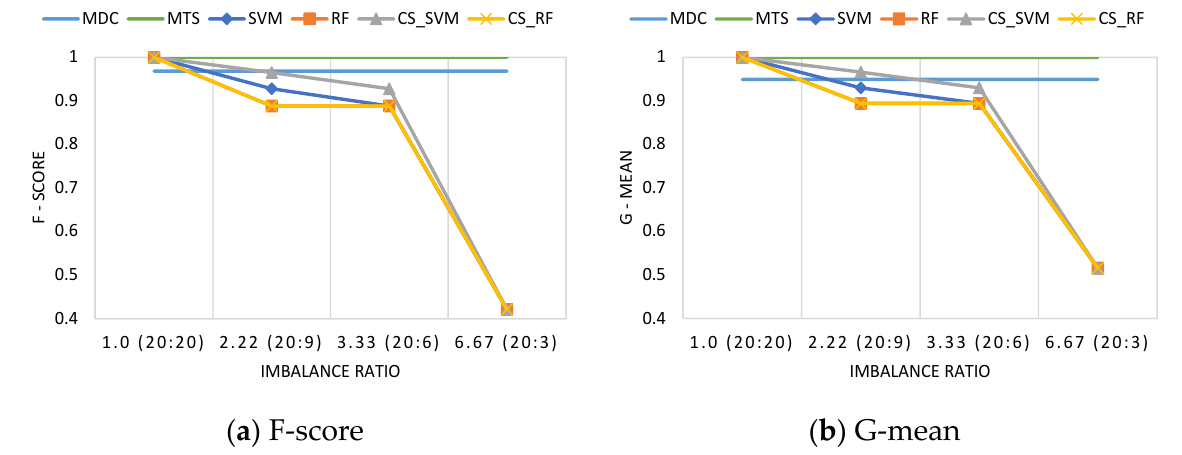
Figure 4. Performance comparison among classifiers according to IRs. ( a ) F-score; ( b ) G-mean. In the case of IR = 1.0, all of the four machine learning-based classifiers also showed perfect performance since there were enough abnormal data in the training data. However, as the number of abnormal data in training sets became smaller, which meant IR was higher, the overall classification performances turned lower. In the case of IR = 2.222 and IR = 3.333, CS_SVM showed similar performance to MDC and less than MTS, but SVM, RF, and CS_RF had lower performances. When IR became 6.667, all the binary classification methods had much lower performances than MDC and